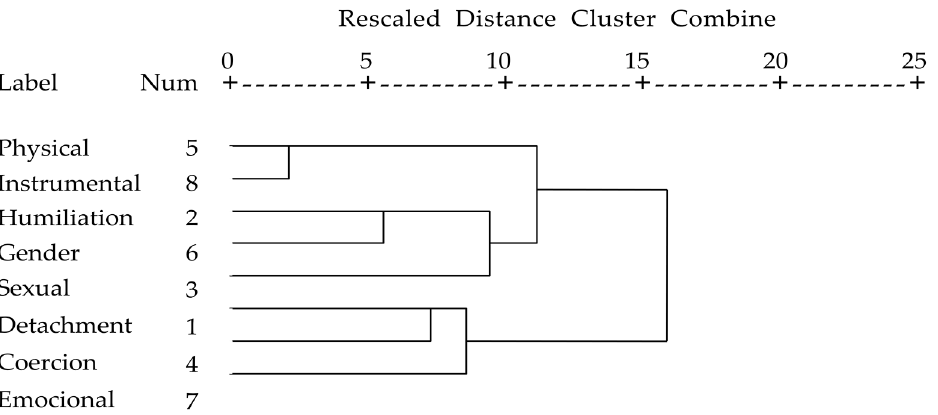
Figure 1. Dendrogram of the grouping of the types of abuse suffered.